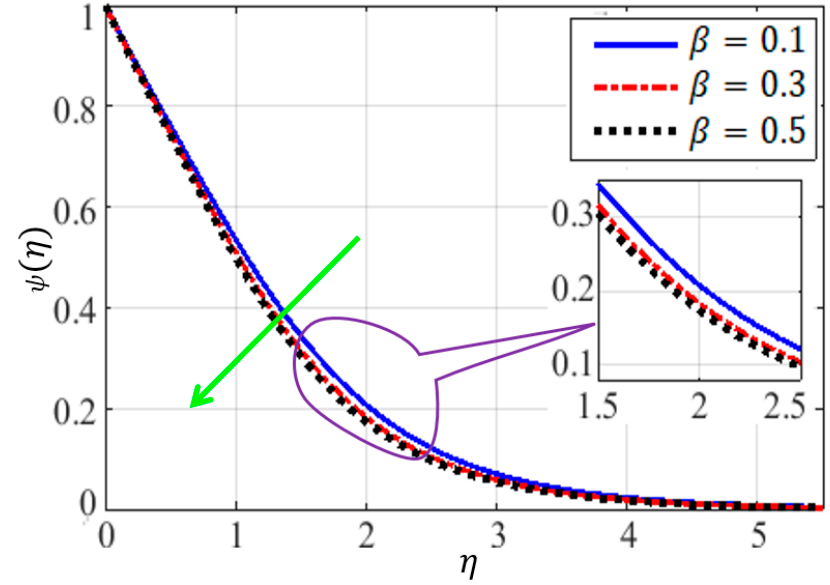
Figure 16. Impact of radiation parameter on density pro fi le of microorganism.